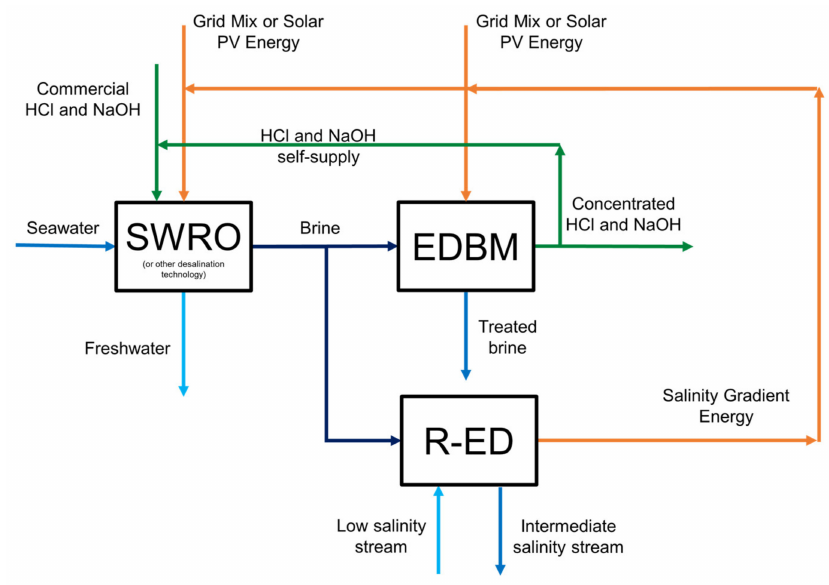
Figure 6. Alternative A4 flow